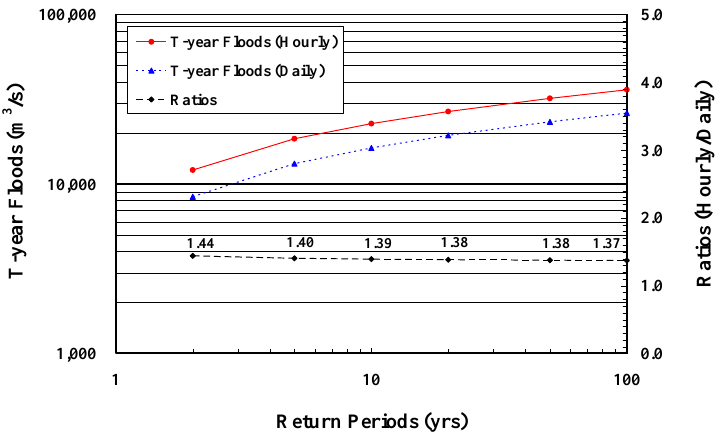
Figure 12. Comparison of the Hourly and Daily Frequency Curve at the Paldang Dam.